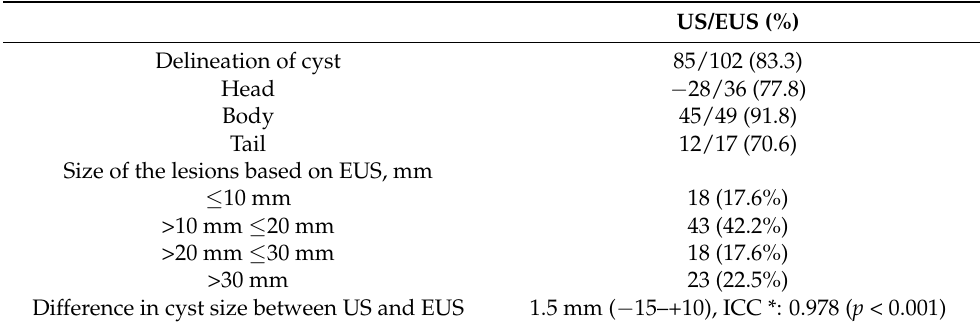
Table 2. Capability of US to delineate PCLs as a reference standard using EUS, and size differences of the lesions between the two